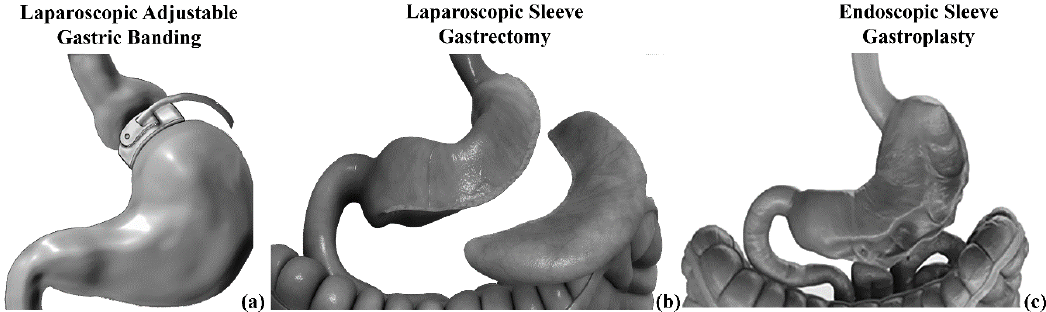
Figure 2. The investigated BS techniques: laparoscopic adjustable gastric banding ( a ), laparoscopic sleeve gastrectomy ( b ), and endoscopic sleeve gastroplasty ( c ).